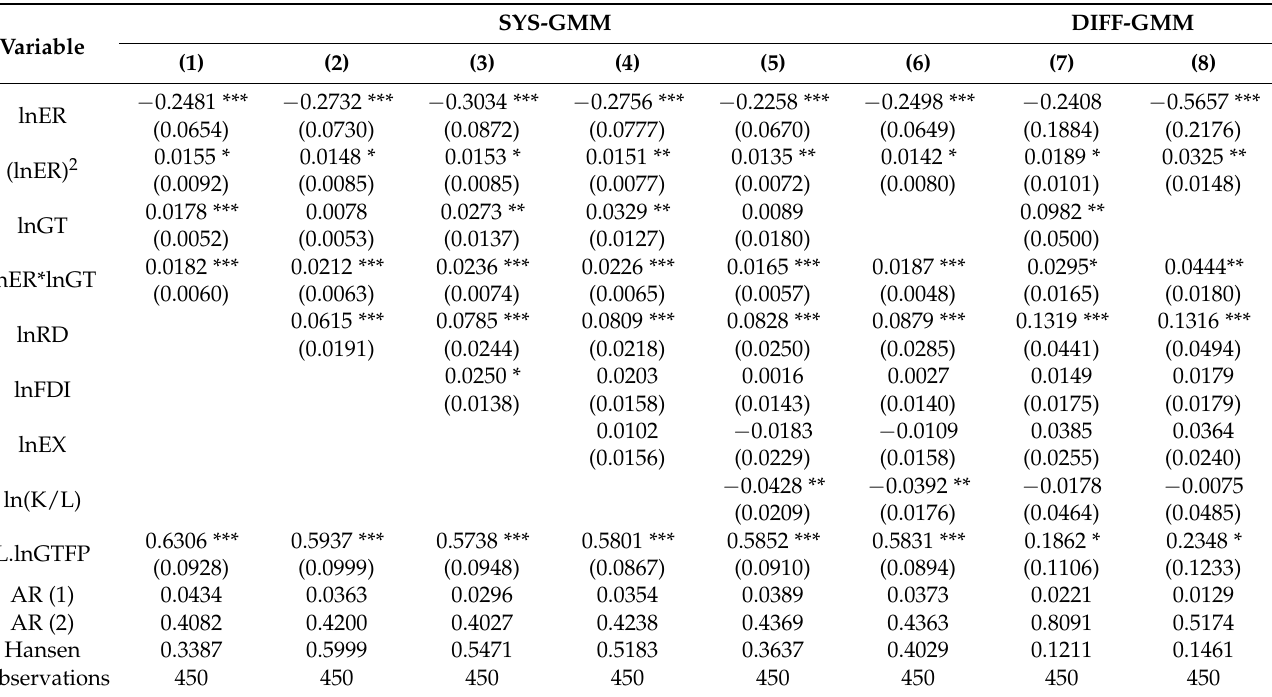
Table 6. The regression results of impact of governance transformation on the Porter